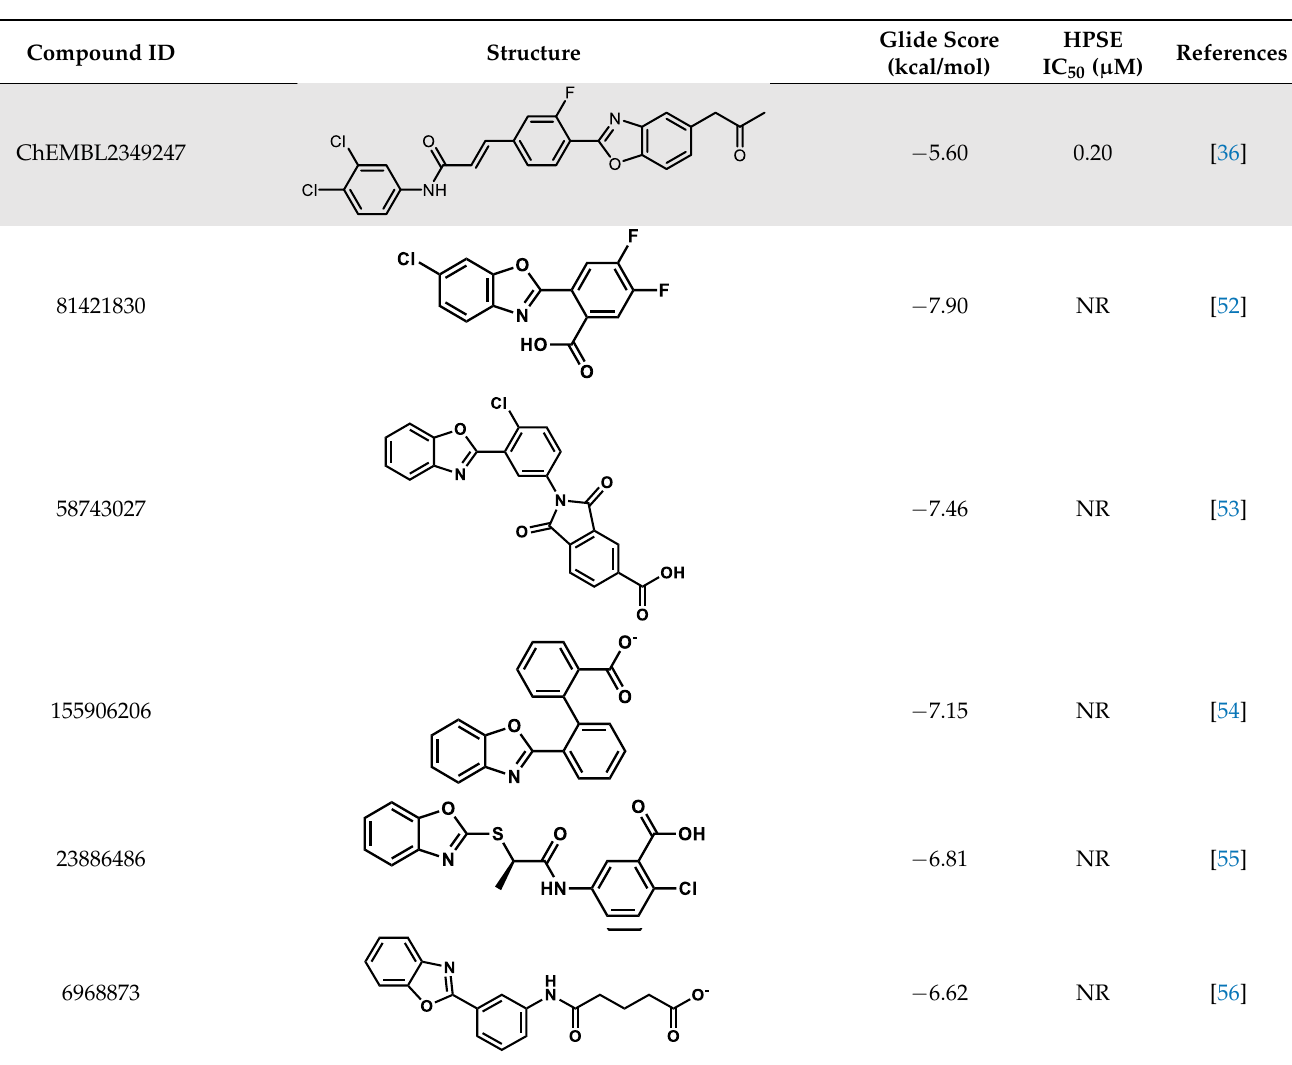
Table 3. Physicochemical descriptors of selected compounds computed with QikProp and struc- tural alerts (PAINS).